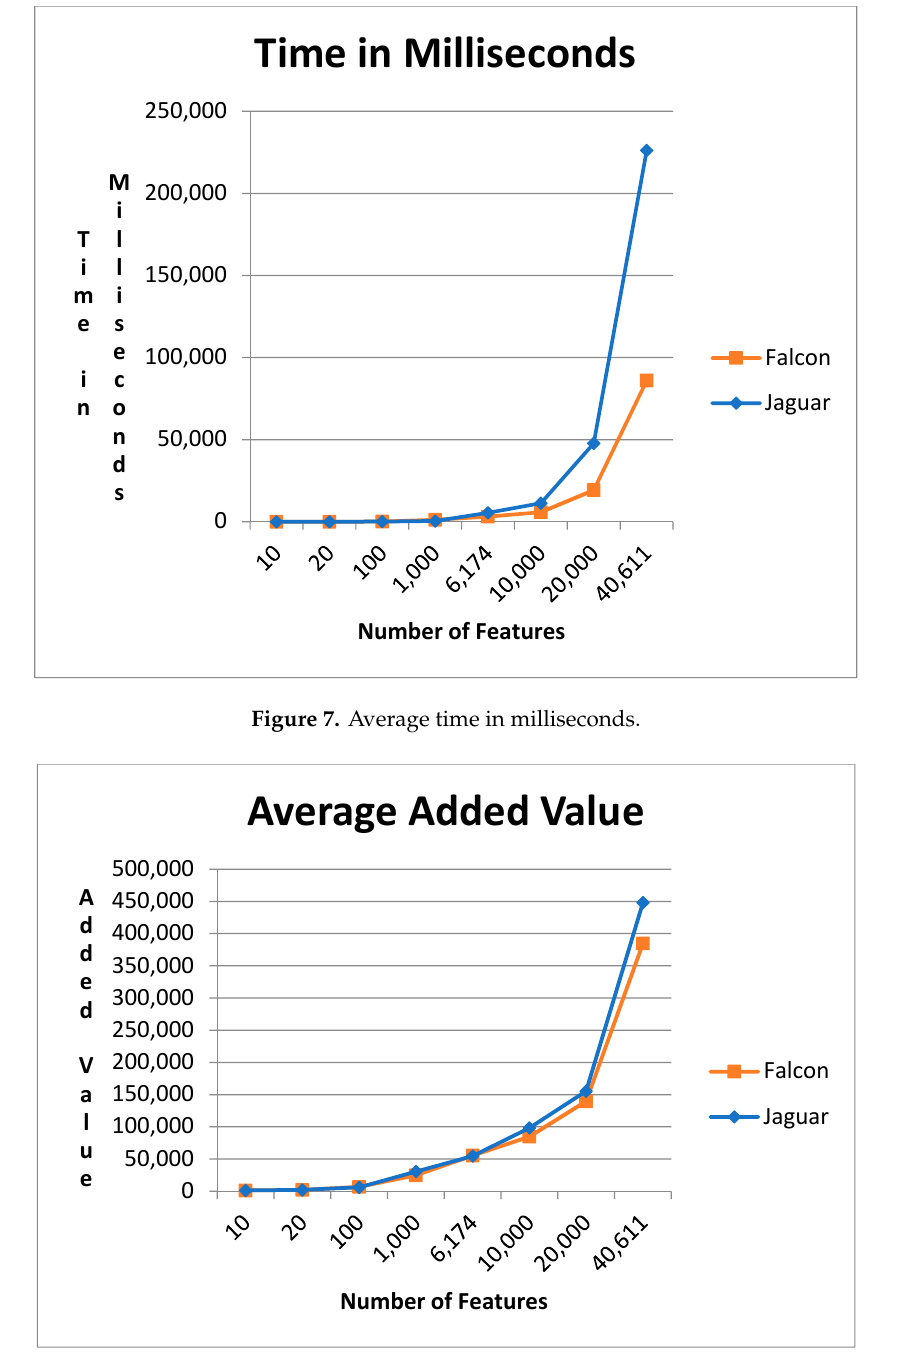
Figure 8. Average added value.